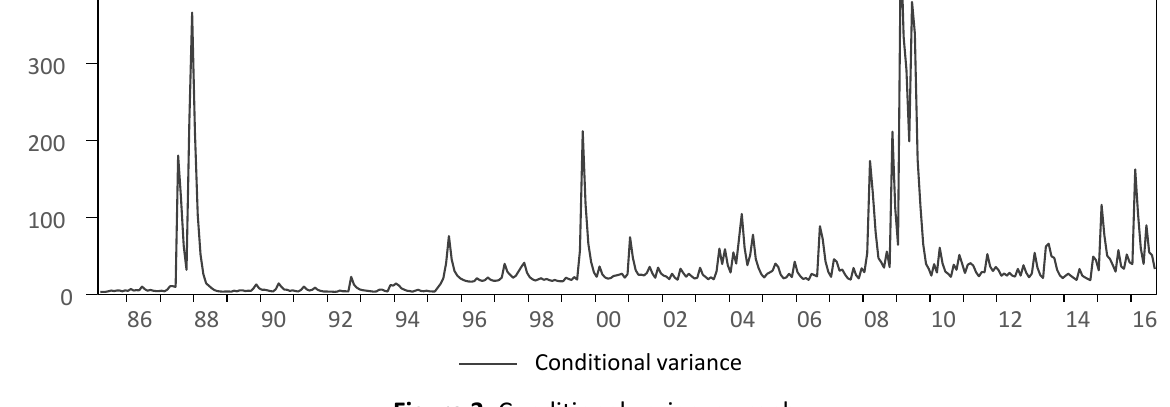
Figure 3. Conditional variance graph